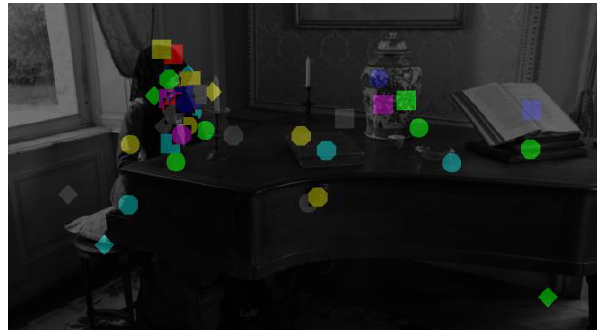
Figure 3. An image from Mademoiselle Paradis . Each colored geometric shape represents one viewer’s gaze point.